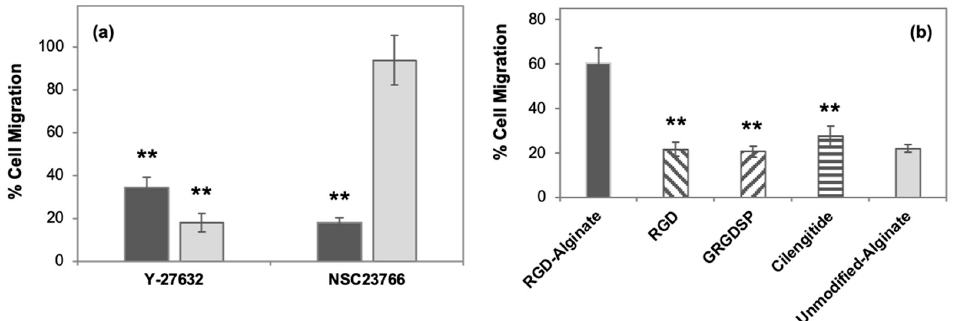
Figure 5. Migration of U87 cells into RGD-modified (dark grey) and unmodified (light grey) alginate gels in the presence of ( a ) Rho GTPase inhibitors Y-27632 and NSC23766, and ( b ) integrin inhibitors RGD, GRGDSP, and cilengitide relative to cell migration in the absence of inhibitors after three days. Error bars represent the standard deviation of three biological samples. Statistical significance was independently evaluated for each inhibitor condition relative to the no-inhibitor control using a two-tailed t -test evaluated with a 95% (*) or 99% (**) confidence interval.